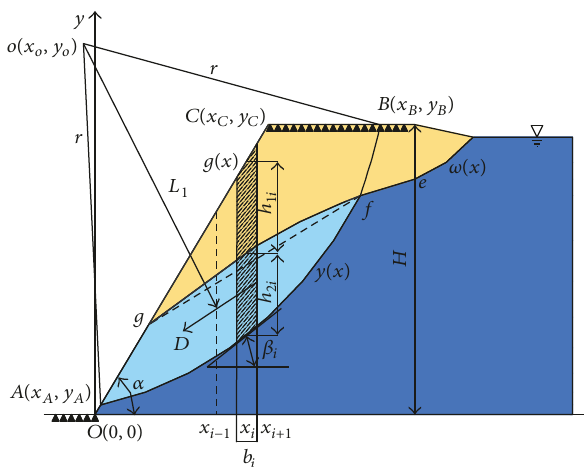
Figure 1: Slope section of the arc of destruction with considering the impact of phreatic